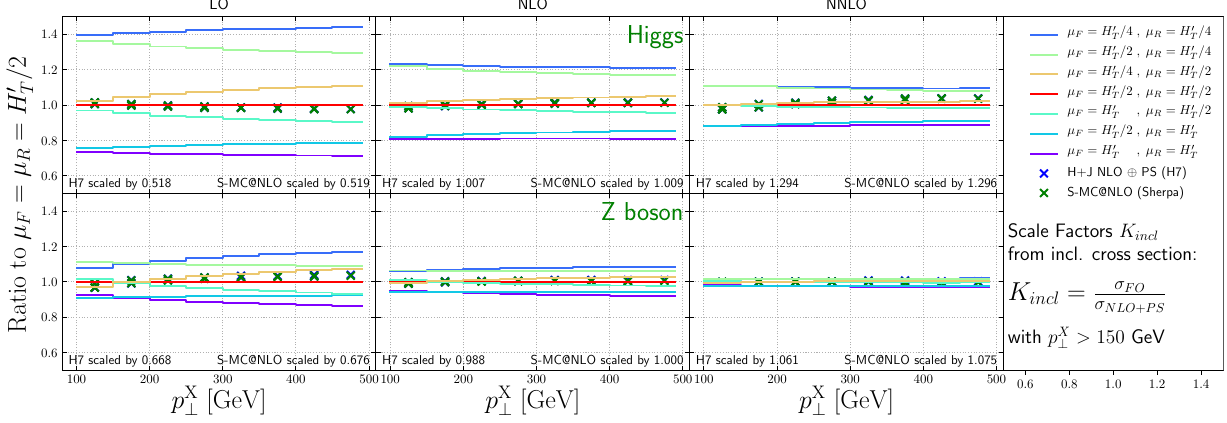
Fig. 4 The scale variations at LO, NLO, and NNLO from NNLOJET for Higgs and Z boson production, as a function of the boson transverse momentum, are shown. For comparison, the nominal NLO NLO + PS